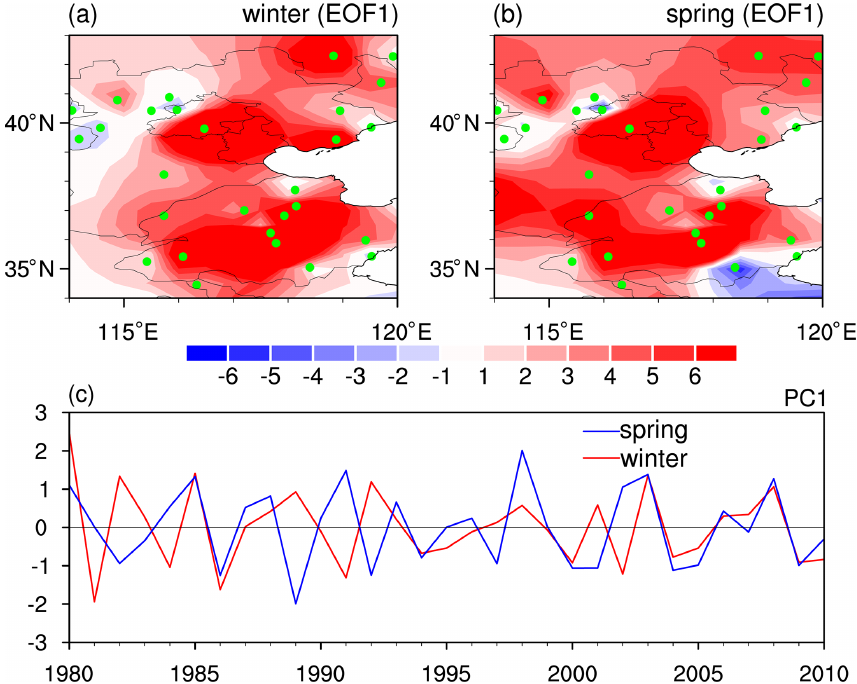
Figure 2. The first EOF mode (EOF1) of interannual anomalies of the DECC in (a) winter and (b) spring over the NCPR (i.e., 34–43 ◦ N and 114–120 ◦ E) for the period of 1979–2010. (c) The corresponding PC time series of the EOF1 of interannual anomalies of the DECC in winter (red line) and spring (blue line). The green dots in (a–b) indicate the stations in the